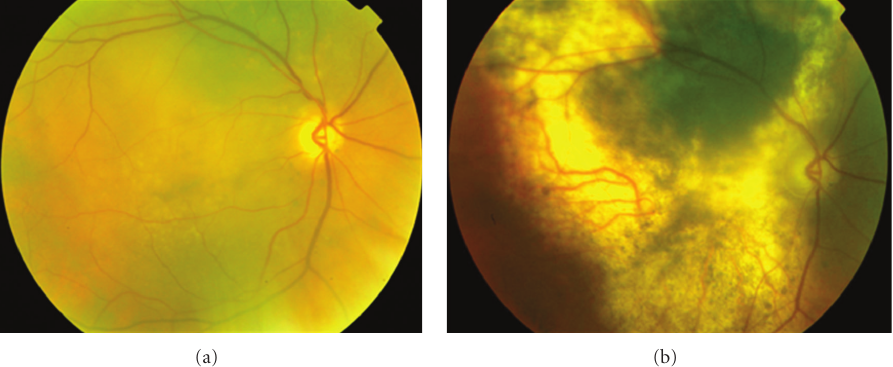
Figure 10: Large choroidal melanoma of the right eye treated with proton beam radiotherapy. Despite extensive atrophy the lesion is flat.